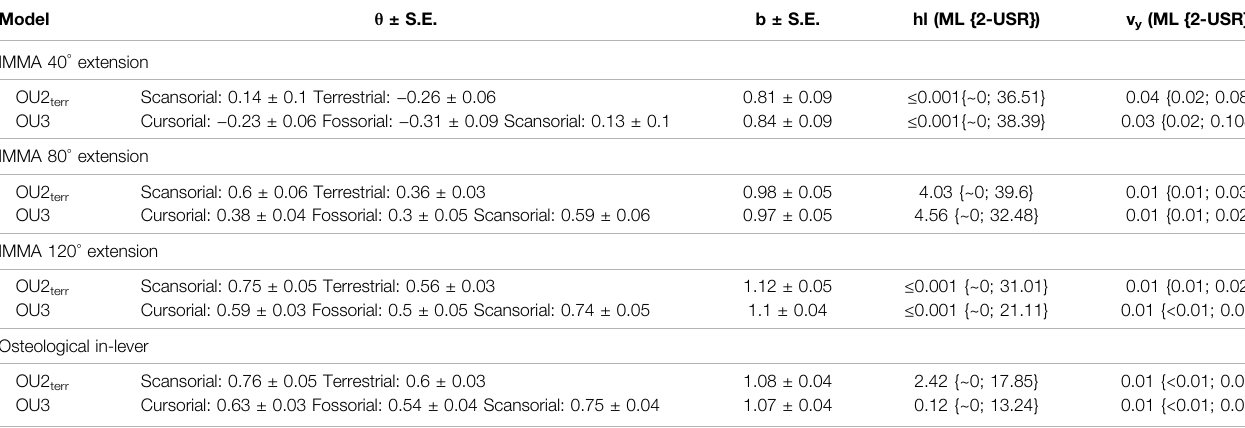
TABLE 2 | Summary statistics of the two most likely macroevolutionary models per trait ( Table 1 ).